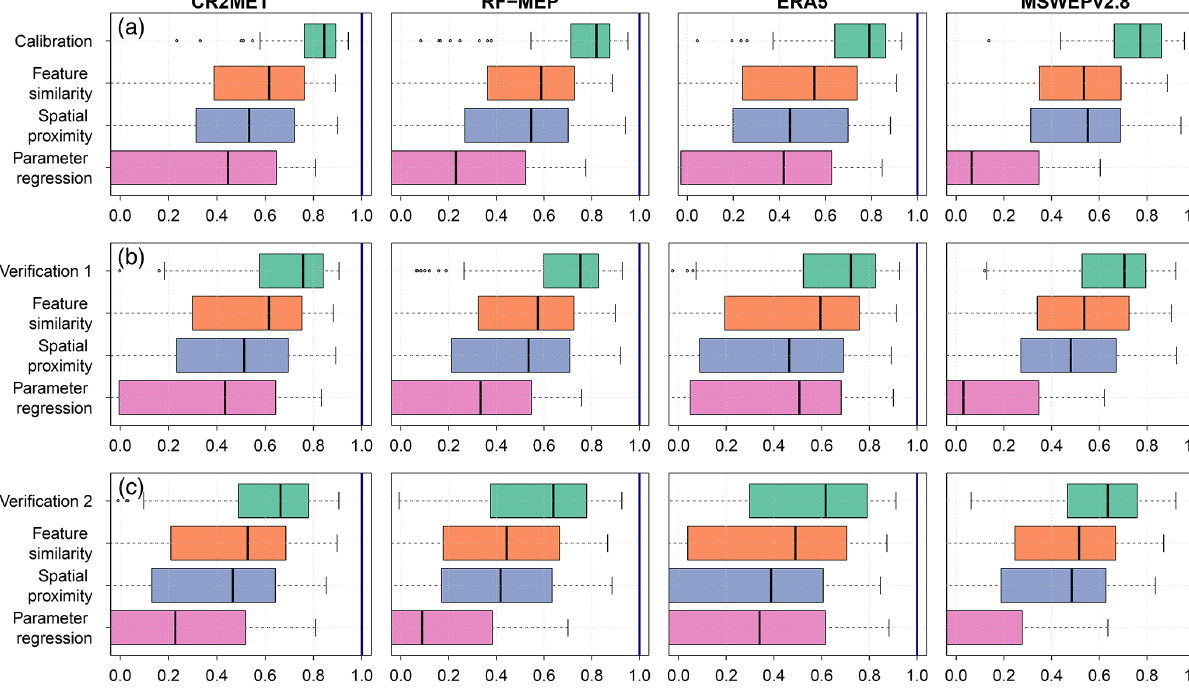
Figure 8. Performance of the regionalisation methods during the (a) calibration (2000–2014), (b) Verification 1 (1990–1999), and (c) Veri- fication 2 (2015–2018)